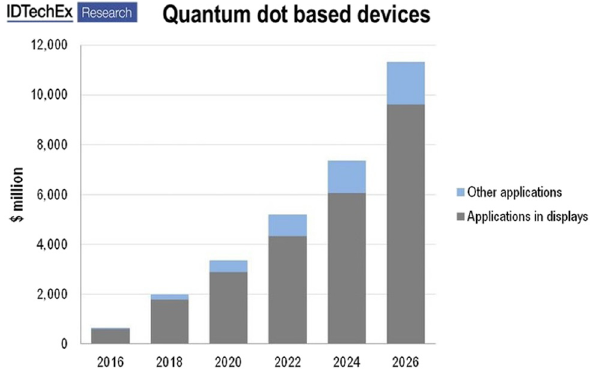
Figure 13: QD devices and components ( $ million ) 2016 – 2026 [ 53 ]